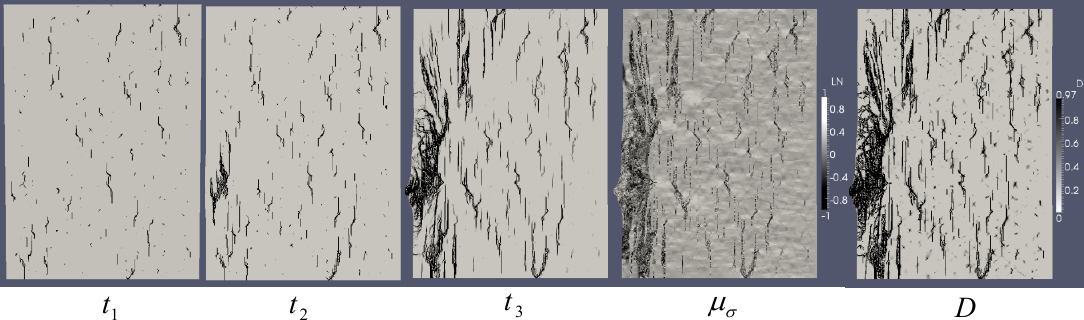
Figure 5. Simulation patterns: inelastic deformations (for three consecutive times), the stressed state ( composite specimen with 15% content of hardening particles in the case of ideal sliding on the loading border.